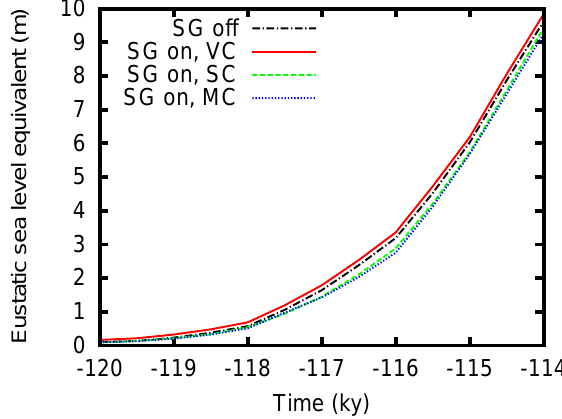
Figure 15. Total ice volume evolution for a simulation over North America during inception with the SG model turned on (SG on) using the parameter vector of run nn9927. Different methods of ice redistribution at the CG level are compared. VC is for ice volume conservation, SC for surface elevation conservation and MC uses the maximum of the previous two methods. “SG off” represents a run where the SG model has been turned off.